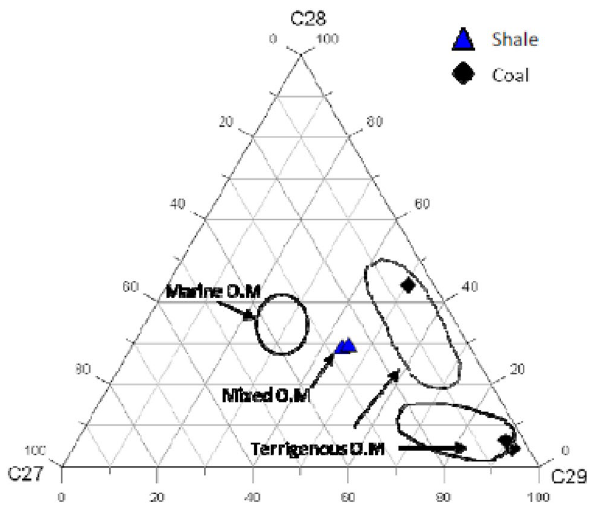
Fig. 15 Ternary diagram of the distribution of C in Maiganga coal and shale, Gombe Formation. The coals are plotted in terrigenous portion due to predominance of C 29 . After Moldowan et al. (1985)